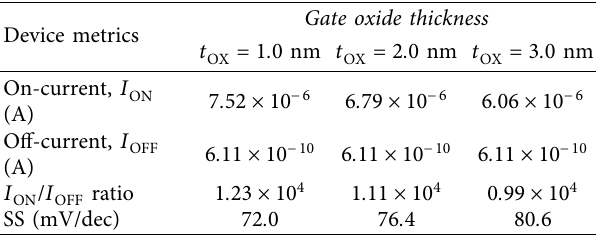
Table 4: Device performance of SB-GNR-FETs with gate oxide thickness